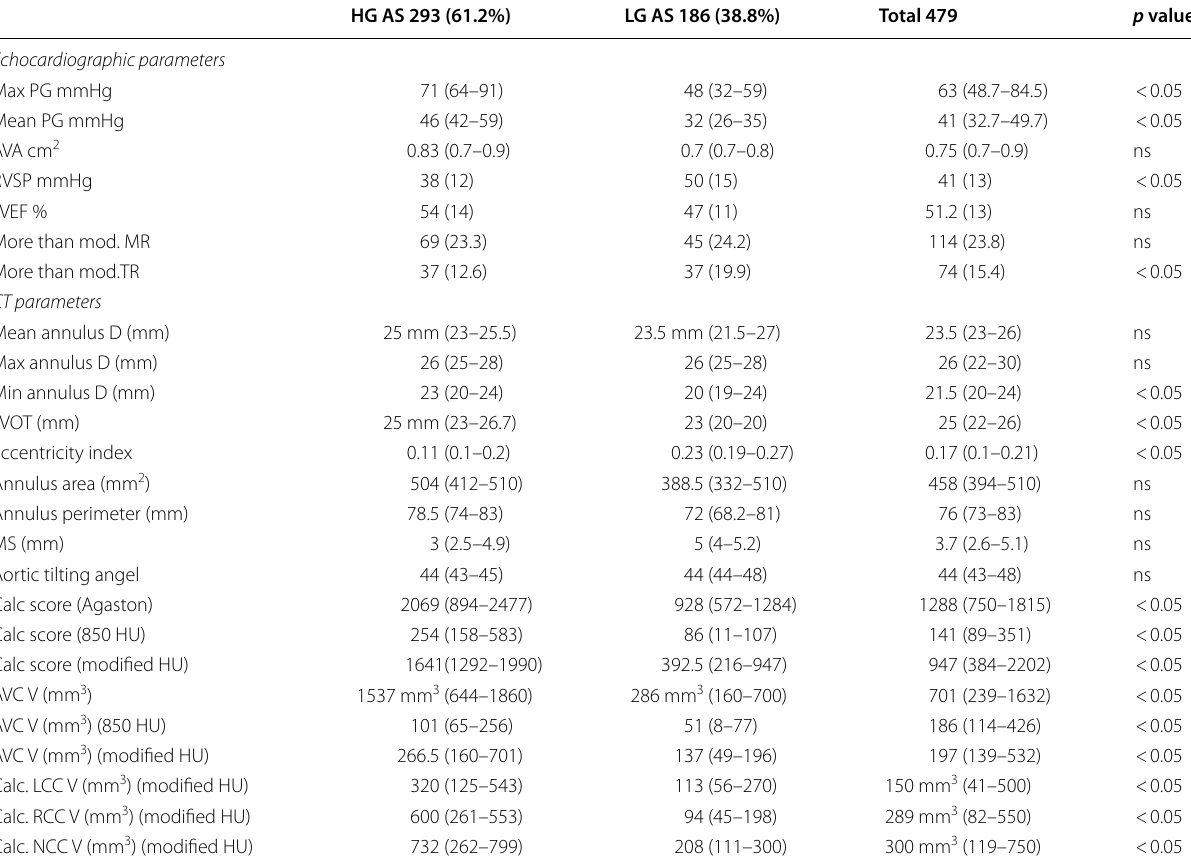
Table 2 Preoperative TTE and CT characteristics